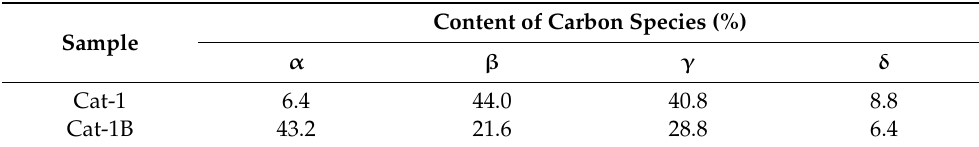
Figure 13. TPH of ( a ) Cat-1 and ( b ) Cat-1B after reaction. Green lines from the left to right are the peaks of α , β , γ , and δ carbon, respectively. The black line is the total fitting curve. Table 10. Peak fitting results of the TPH curves of Cat-1 and